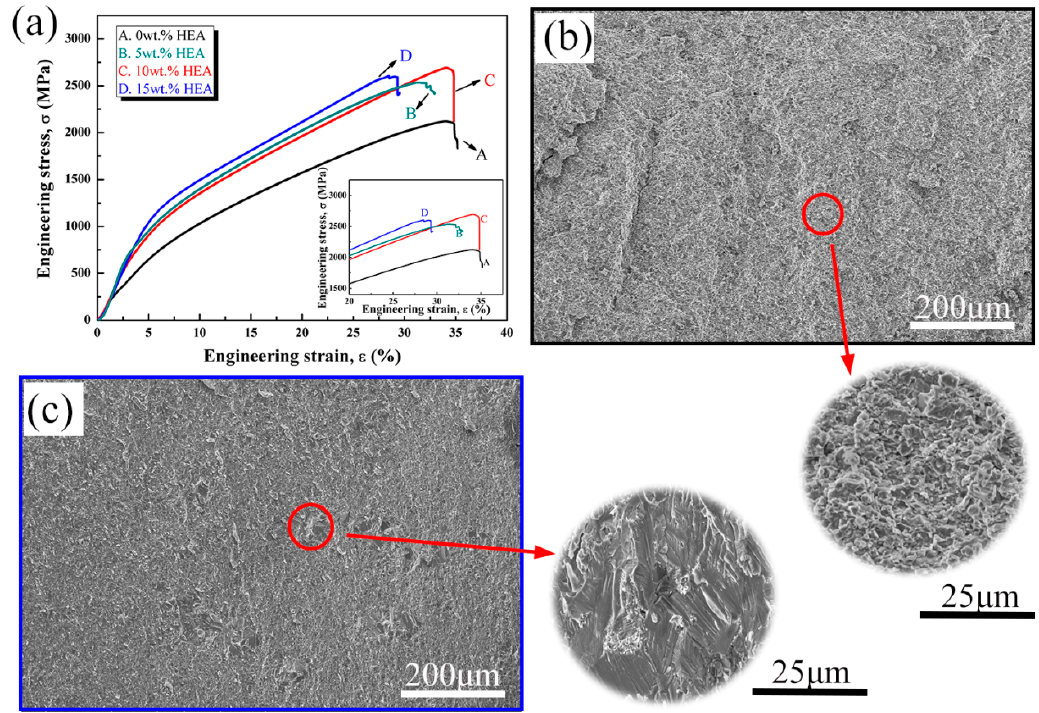
Figure 8. Compression stress-strain curves ( a ) and the fracture surface images: ( b ) 0 wt.% HEA, and ( c ) 15 wt.% HEA.